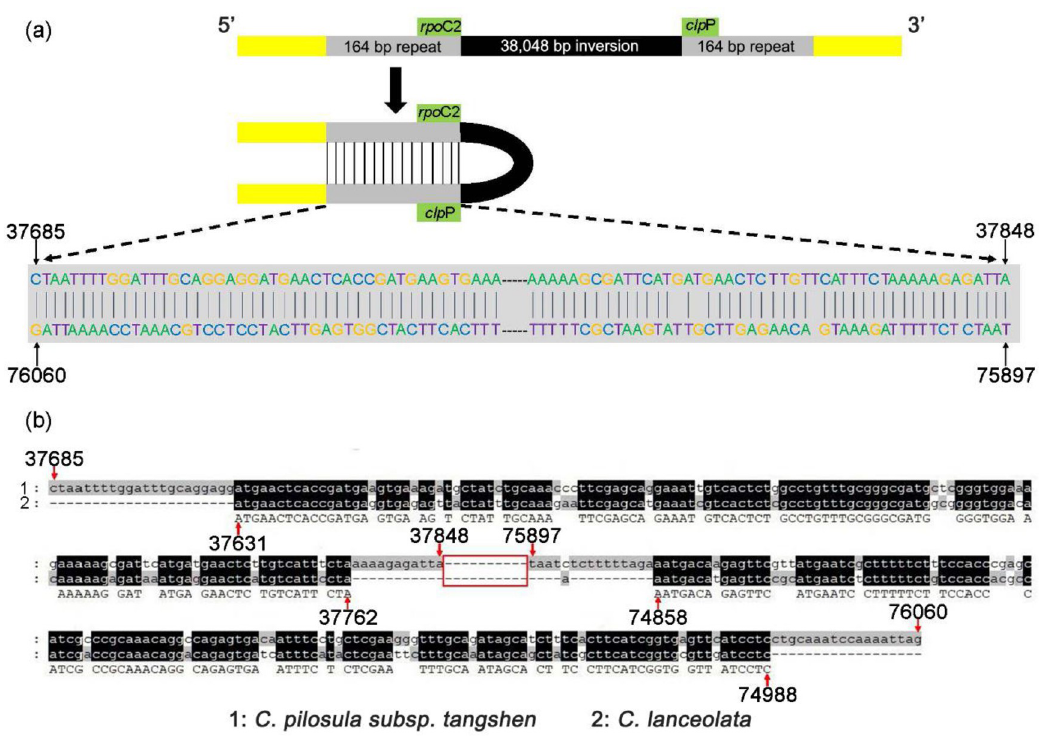
Fig 5. Alignment of two repeat sequences at both ends of the inversion in C . pilosula subsp. tangshen . (a) The schematic representation of the inversion region and the two repeat sequences. The black shaded area represents the inversion region. Grey areas links repeat sequences at both ends. The yellow areas represent the sequences at both ends of the repeat sequences. rpo C2 and clp P represent the genes closest to the inversion region. The direction was from 5’ to 3’. The number on the arrows represents the starting and ending positions of the two repeat sequences, respectively. The dash in the middle of the sequences represents the omitted sequence. (b) Alignment of the repeat sequences in C . pilosula subsp. tangshen and C . lanceolata . The black shading represents the two repeat unit sequences. The two repeat units are palindromic. The red box in the middle represents the omitted sequences between the two repeat units. The numbers pointed by the red arrows represent the start and end positions of the two repeat units in C . pilosula subsp. tangshen and C . lanceolata . The repeat sequence in C . pilosula subsp. tangshen is longer than that in C . lanceolata . The code for the species was listed below this